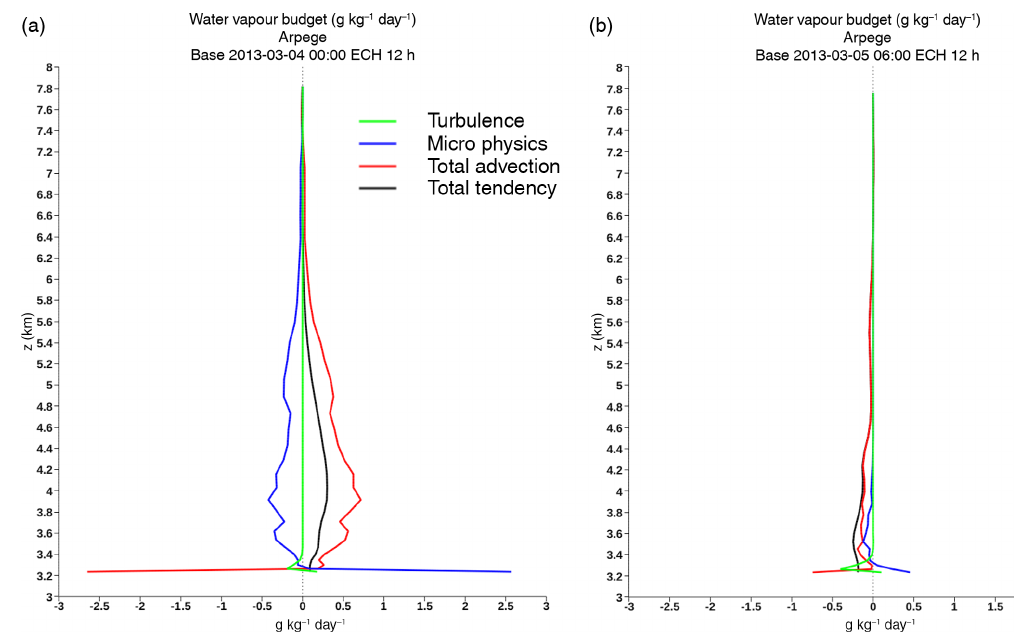
Figure 17. (a) Water vapour budget calculated by ARPEGE on 4 March 2013 over the 12h period 00:00–12:00UTC induced by turbulence (green), microphysics (blue) and total advection (red), showing the total tendency (black). (b) Same as (a) but on 5 March 2013 over the 12h period